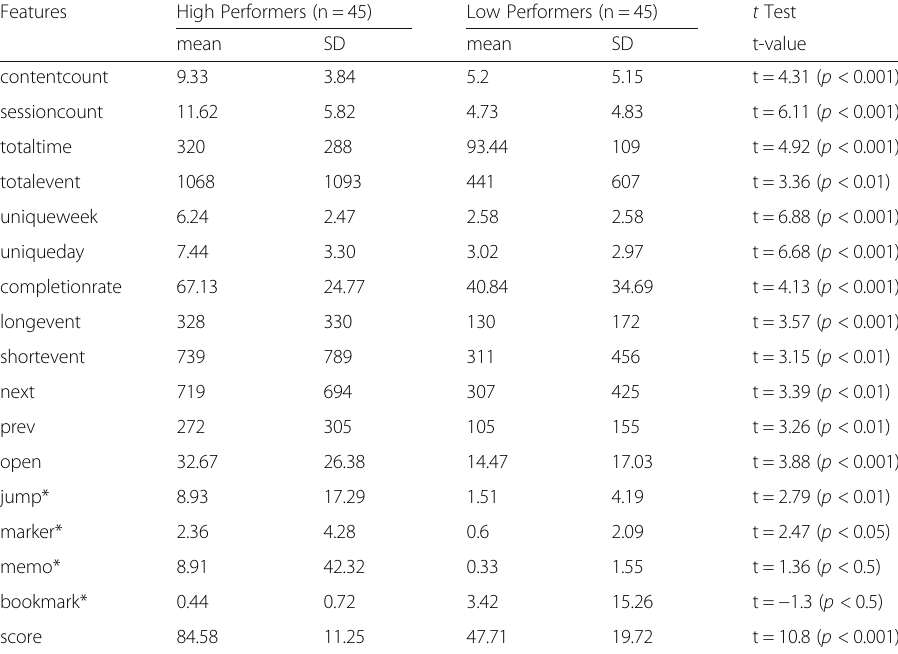
Table 3 Descriptive statistics of features